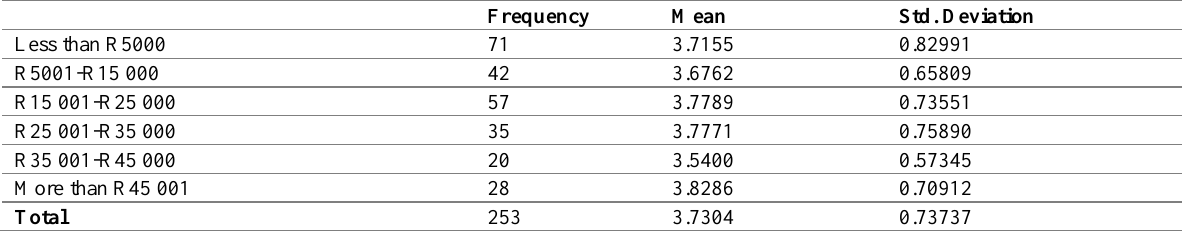
Table 10: Descriptive statistics between groups